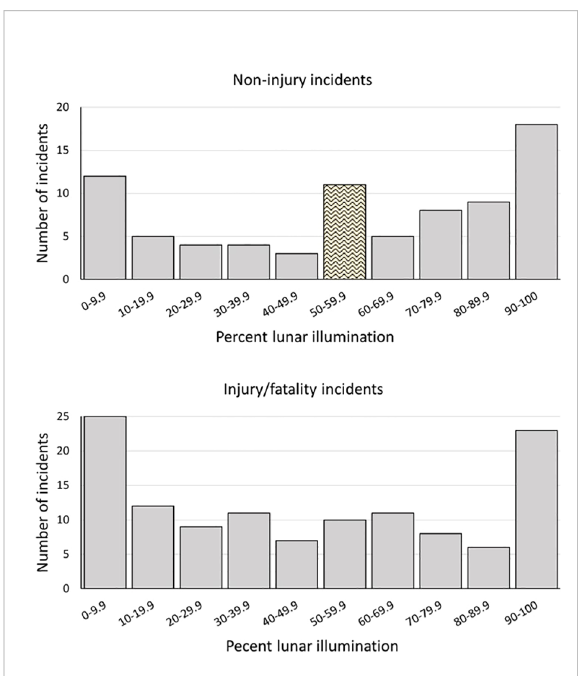
FIGURE 8 Lunar phase and number of documented California shark incidents by category: non-injury incidents, and non-fatal injuries and fatalities, 1950 to 2021. The yellow bar represents shark incident counts that were signi fi cantly greater than the expected number of counts for that given lunar illumination